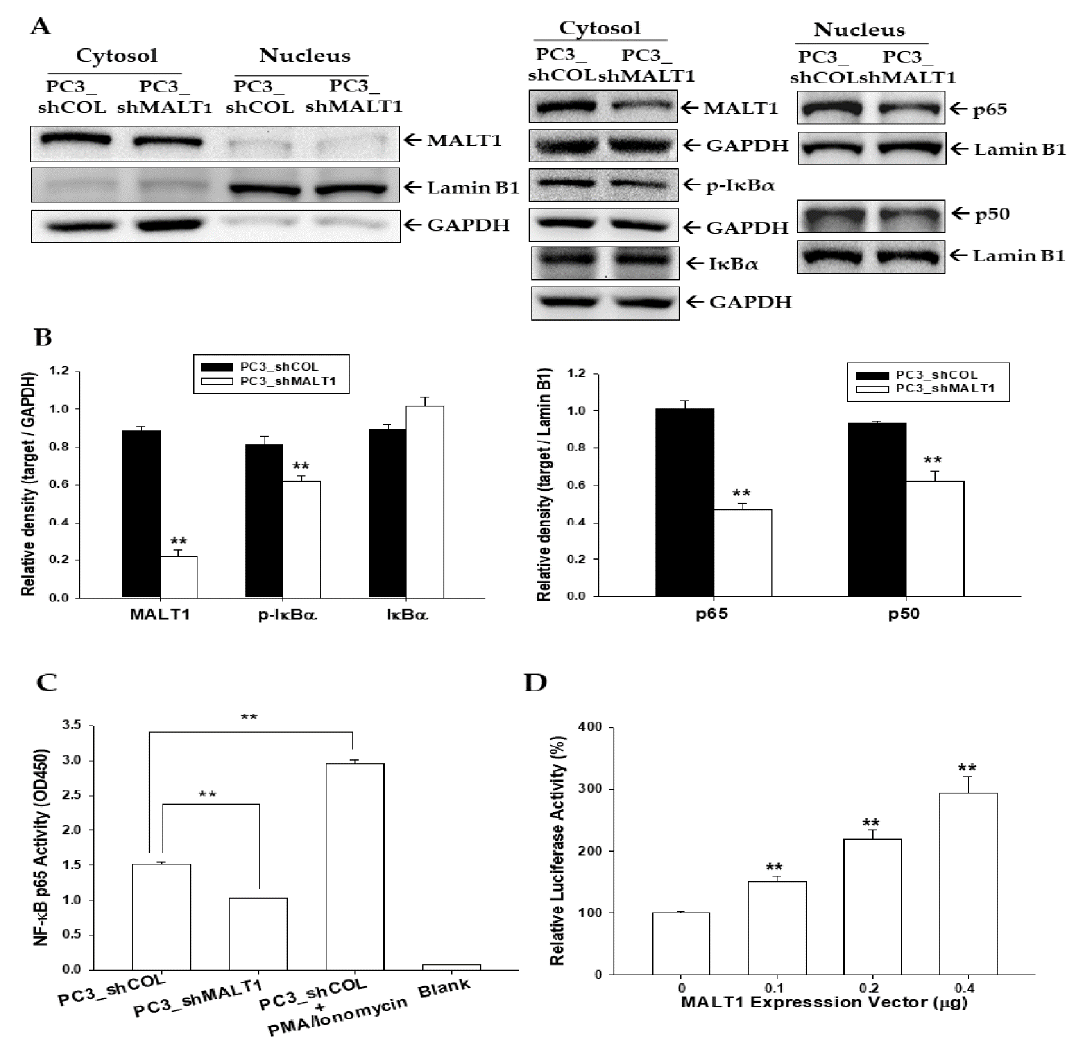
Figure 5. Modulation of MALT1 on NF-κB activity in prostate carcinoma PC-3 cells. ( A ) Expressions of MALT1, IκBα, phospho- IκBα, p65, p50, Lamin B1, and GAPDH in PC3_shCOL and PC3_shMALT1 cells after separation of nuclear and cytoplasmic fractions determined by immunoblot assays. ( B ) The data of relative density are expressed as the intensity of the protein band produced from the target gene/GAPDH or Lamin B1 as indicated ( n = 3). ( C ) The NF-κB (p65) binding activity in PC3_shCOL cells, PC3_shMALT1 cells, and PMA/Ionomycin-treated PC-3 cells. ** p < 0.01. ( D ) The reporter activity of NF-κB reporter vector cotransfected with various dosages of the MALT1 expression vectors, as indicated in the PC-3 cells. Data are expressed as the mean percentage ± SE ( n = 6) of luciferase activity relative to the mock-transfected group.